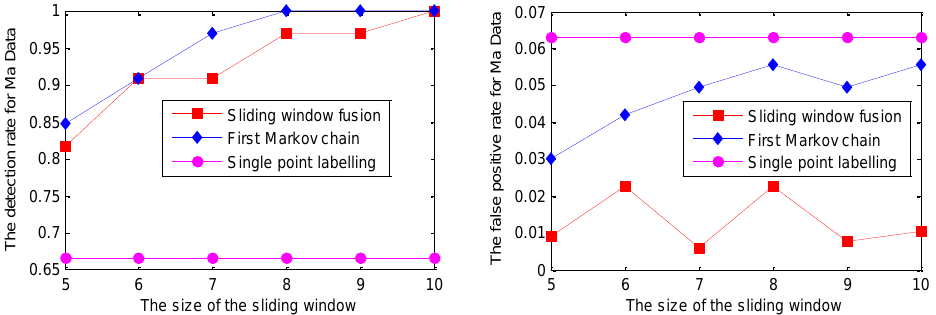
Figure 12. The detection results for Ma Data with the GPR model under different sliding window sizes.